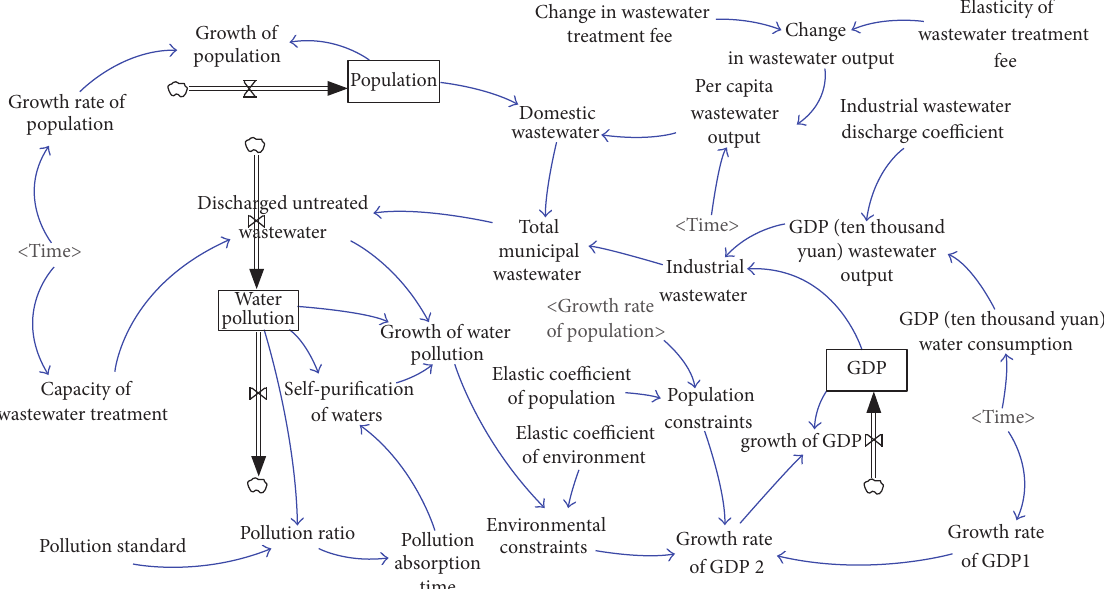
Figure 2: The stock-flow diagram of the